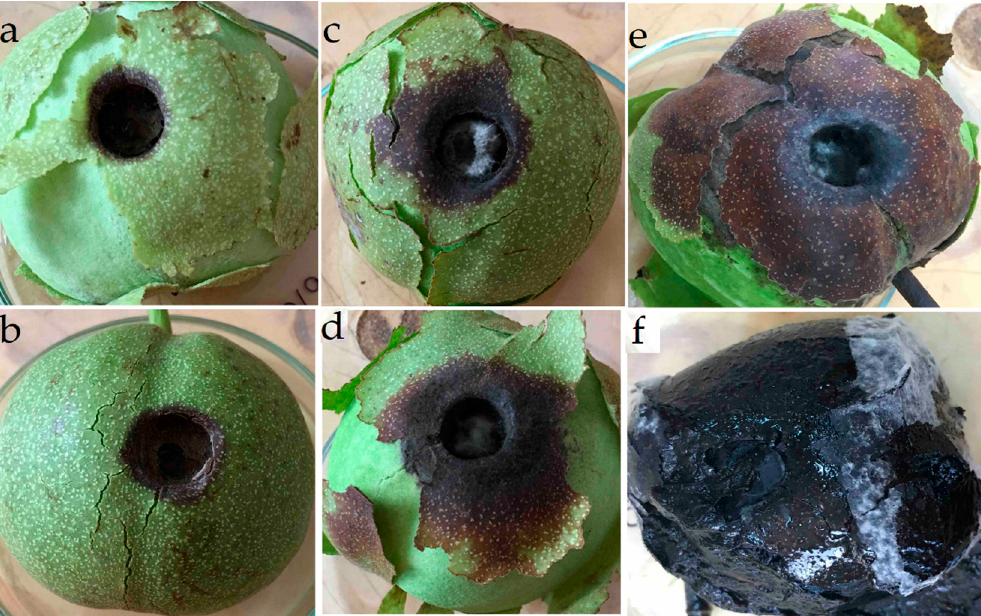
Figure 2. The size of the disease lesions three weeks after wounding and inoculation with fungal mycelium, and the classification of the progress of necrosis. ( a ) 0—mock wound; ( b ) 1—secondary lesion visible around the wound; ( c ) 2—more extensive brownish secondary lesion; ( d ) 3—brownish diseased tissue on half of the husk; ( e ) 4— 3 of the fruit is affected; ( f ) 5—entirely rotten husk. 4 The McKinney index (Imc%), a measure of disease severity, was calculated both